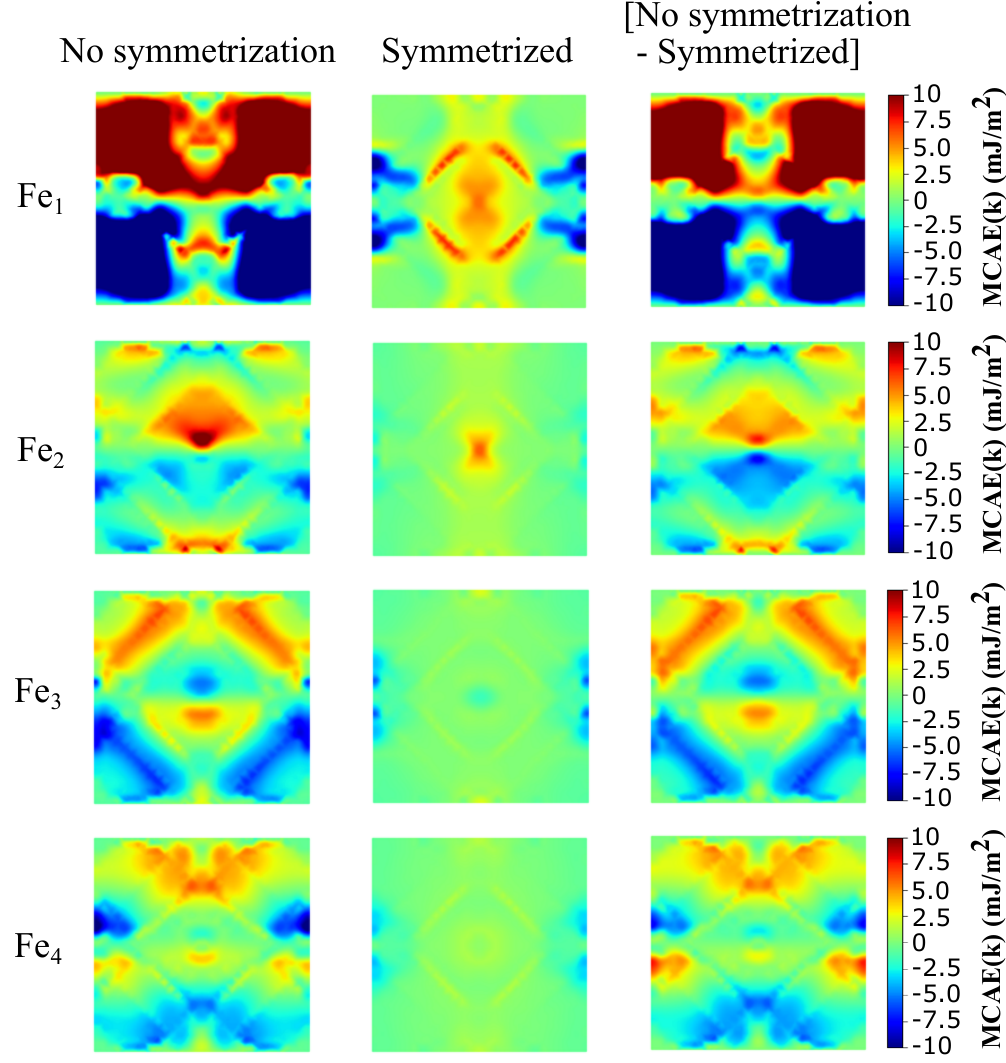
Figure A1. Atomic k-resolved MCAE for structure-I, evaluated with the magnetization directions along [100] and [001]. The 1st, 2nd, and 3rd columns specify the bare data of no symmetrization, symmetrized component, and asymmetrized component,